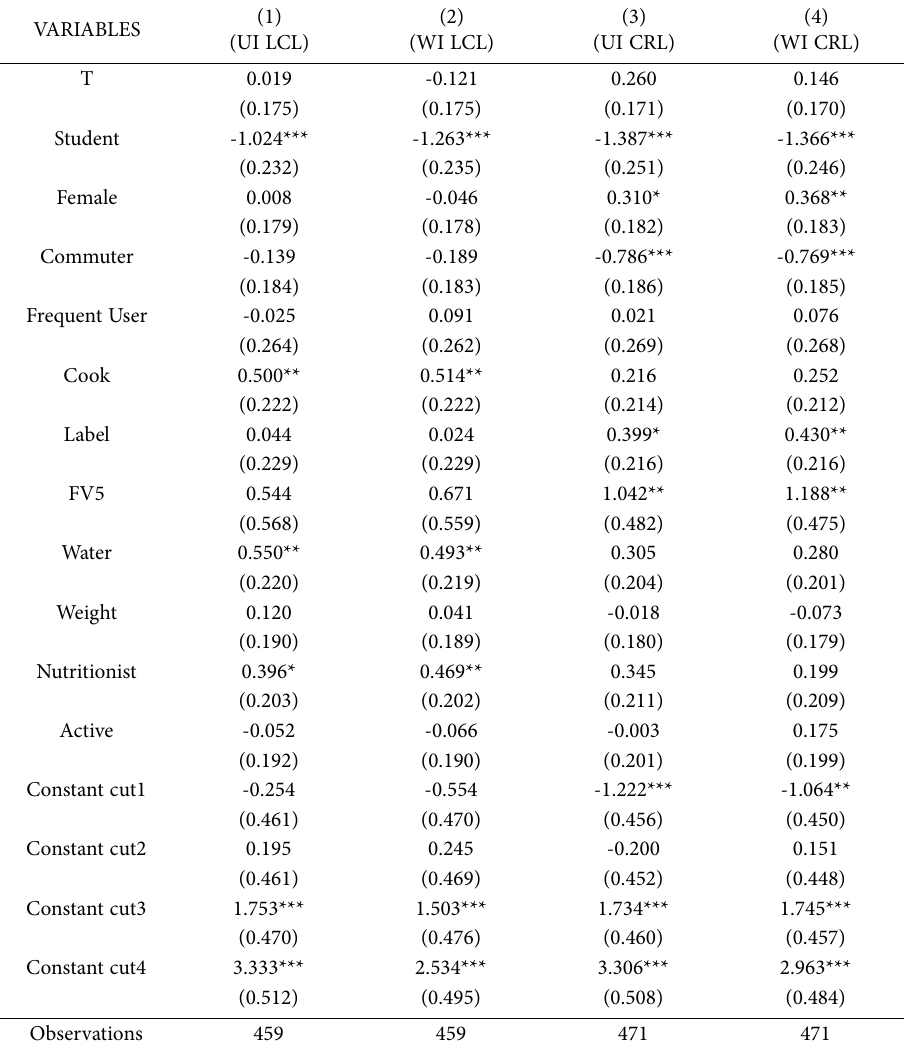
Table 4. Results - Ordered Logit